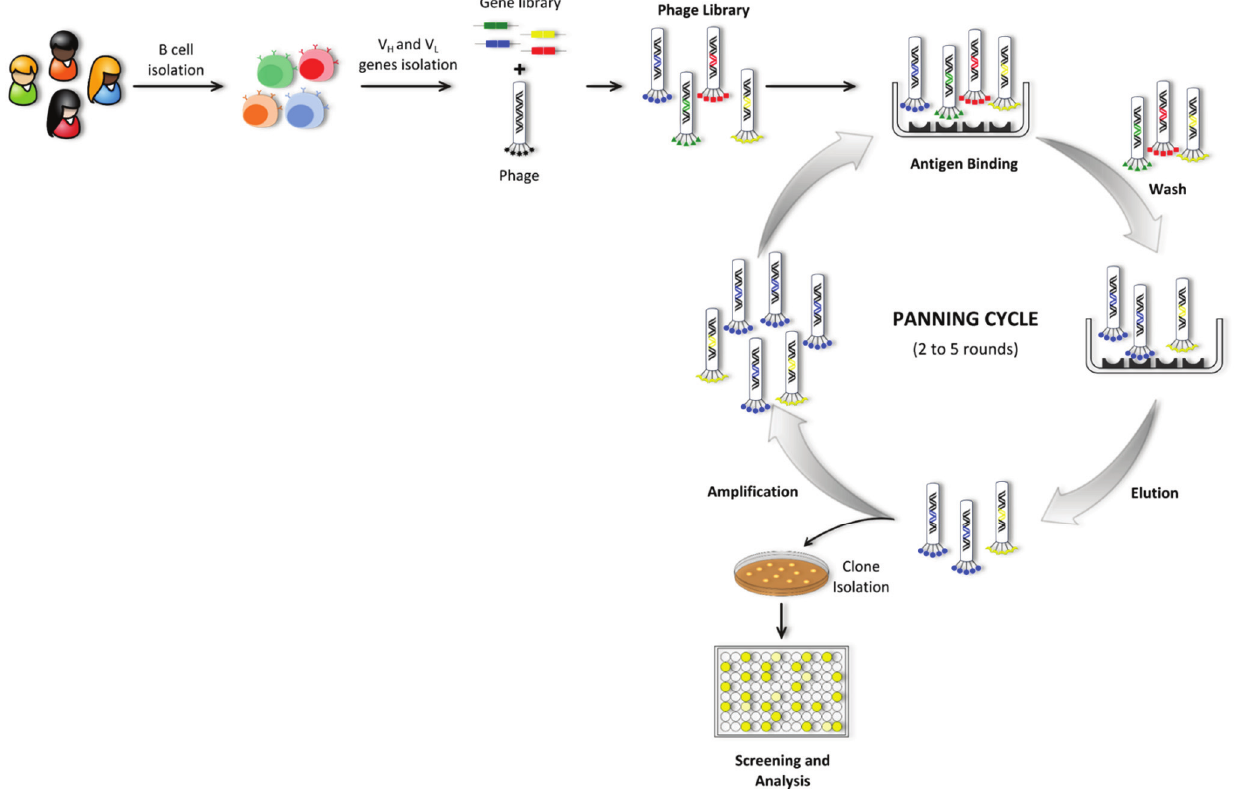
Figure 6. Schematic representation of the phage display technology. This technique includes three main steps that begin with antibody phage library construction and antibody fragments’ display onto the phage surface, followed by several rounds of selection against the target antigen (termed panning cycle) and lastly, clone isolation and subsequent screening for fragments with desired